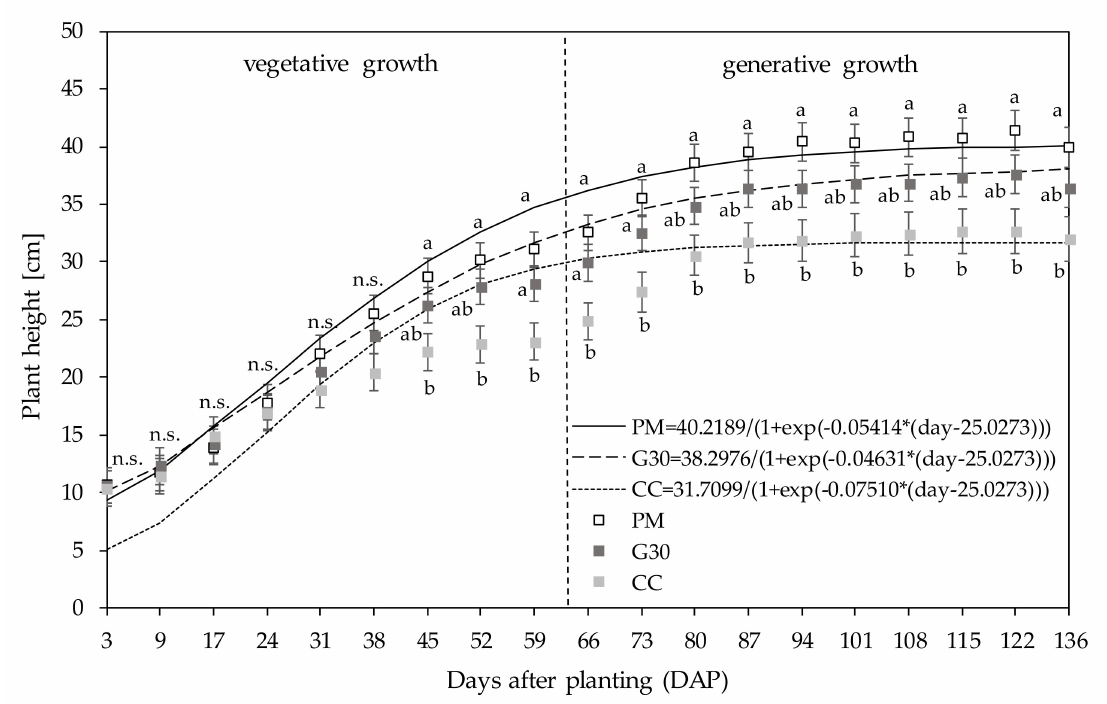
Figure 1. Mean plant height of genotypes treated with peat-mix media (PM), peat-mix + 30% green fibre (G30) compared to those grown in 100% coco coir fibre (CC) through 136 days after planting (DAP). Means with at least one identical lowercase letter did not di ff er significantly at α = 0.05. Table 2. The p-values correspond to global F tests for di ff erences between the parameters of the logistic function f ( day )